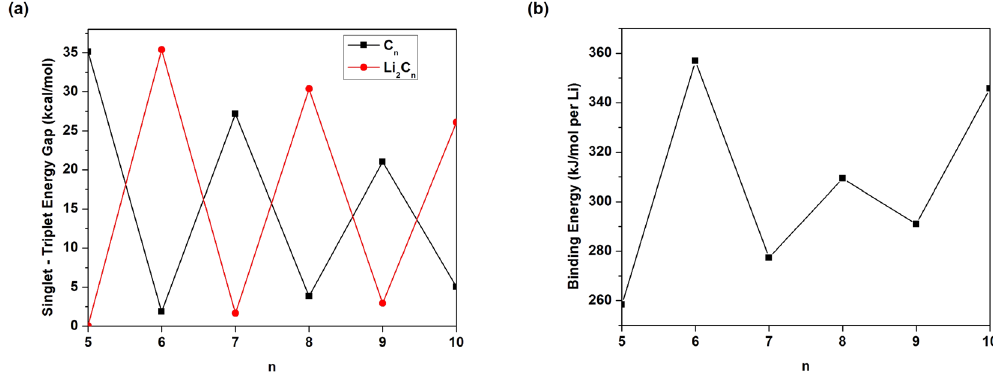
Figure 2. ( a ) Singlet-triplet energy (ST) gap of C n /Li 2 C n and ( b ) Li binding energy on C n as a function of the chain length, calculated using